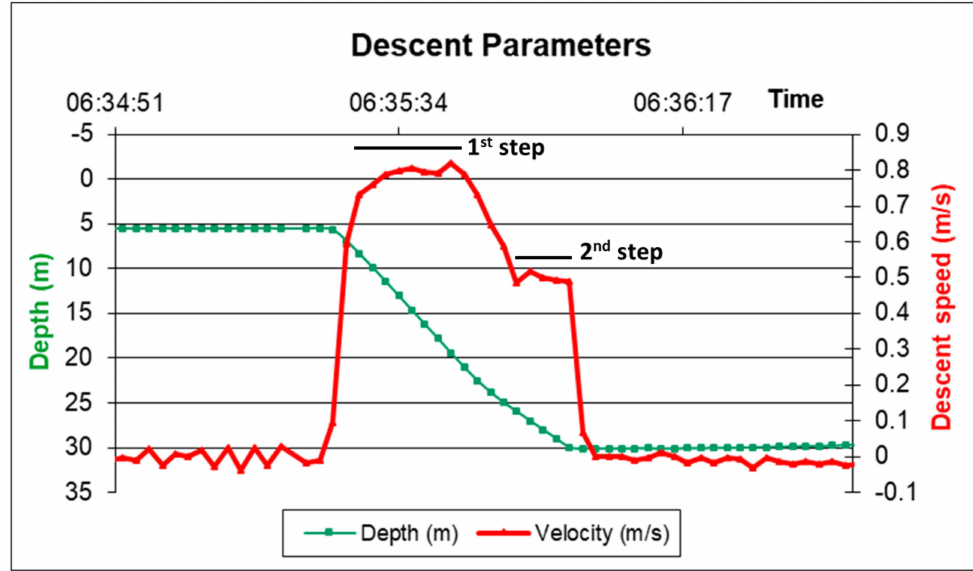
Figure 3. Amerigo Lander descent data. The data refer to the setup with three benthic chambers. Red line: Descent and landing speed. First step: Speed before activation of the first 2-buoy array; Second step: Speed after activation of the two buoys of the recovery pole. Green line: Depth